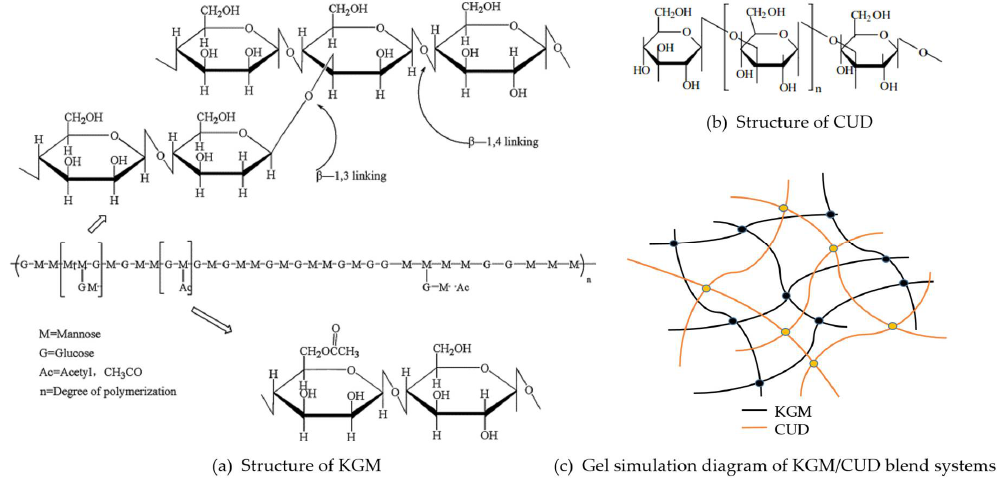
Figure 10. Structure of ( a ) KGM and ( b ) CUD and ( c ) gel simulation diagram of KGM / CUD blend systems.